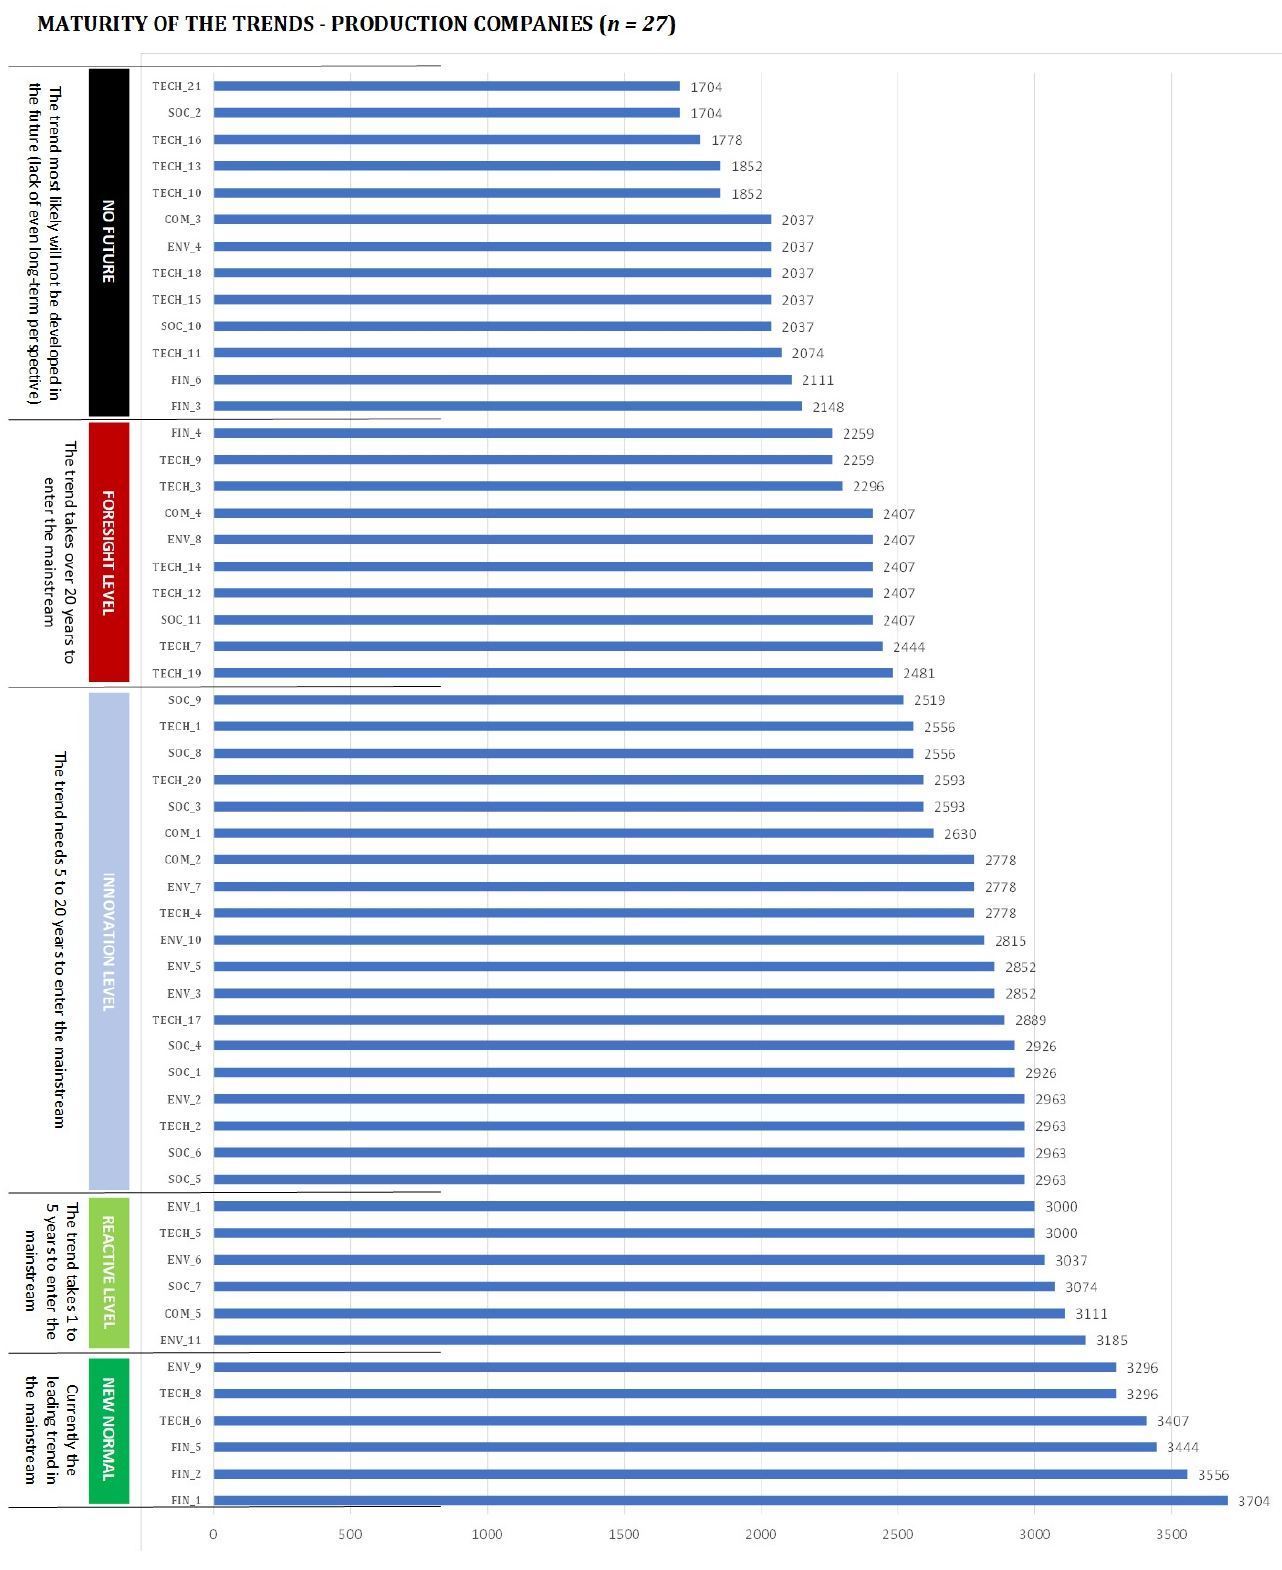
Figure 3. Map of Maturity of S.T.F.E.C. SMART management trends—production companies. Source: Own elaboration.